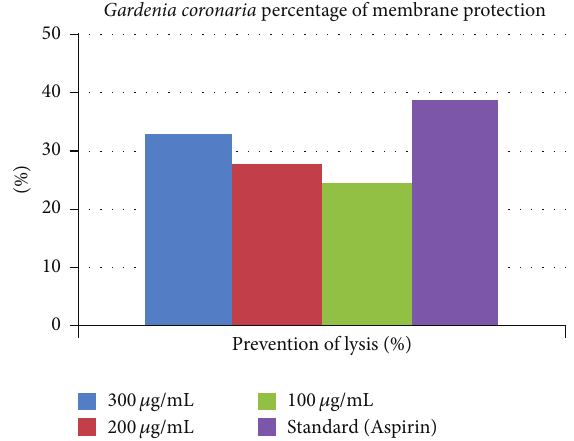
Figure 2: The bar chart above represents the percentage of mem- brane protection of the Methanolic leaves extract with a reference to Aspirin 100 𝜇 g/mL as standard.